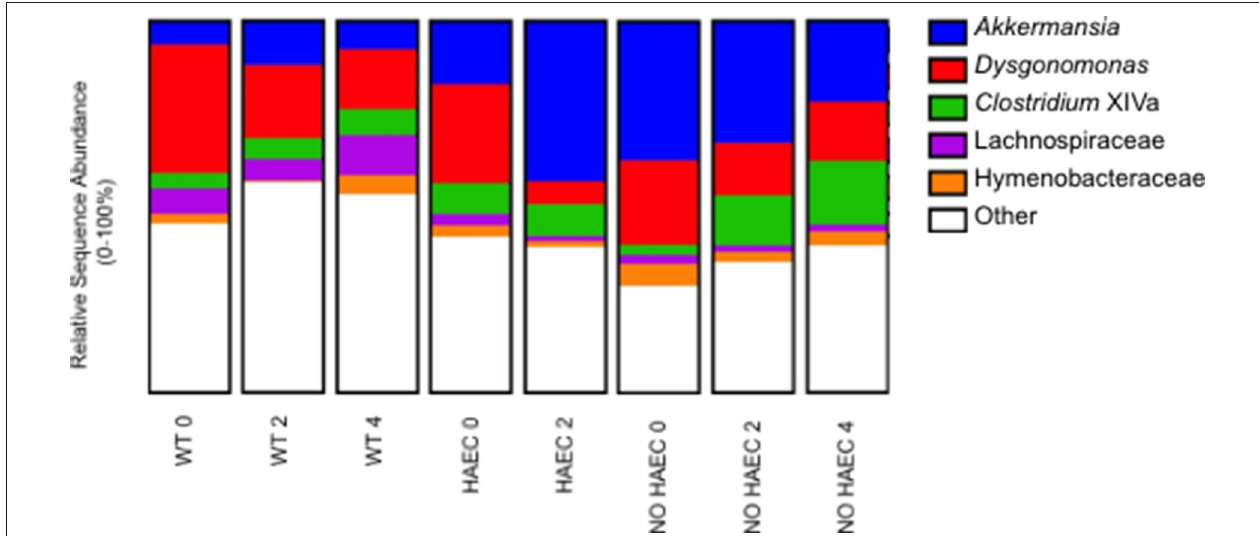
Figure 6 | Fecal bacterial genera at several times in relation to pull-through surgery from WT and Ednrb −/− mice with and without HAEC. Data were generated by analyses of 16S rRNA gene sequences. n = 8 (WT 0, 2, 4), 6 (HAEC 0, 2), 4 (NO HAEC 0, 2), 2 (NO HAEC